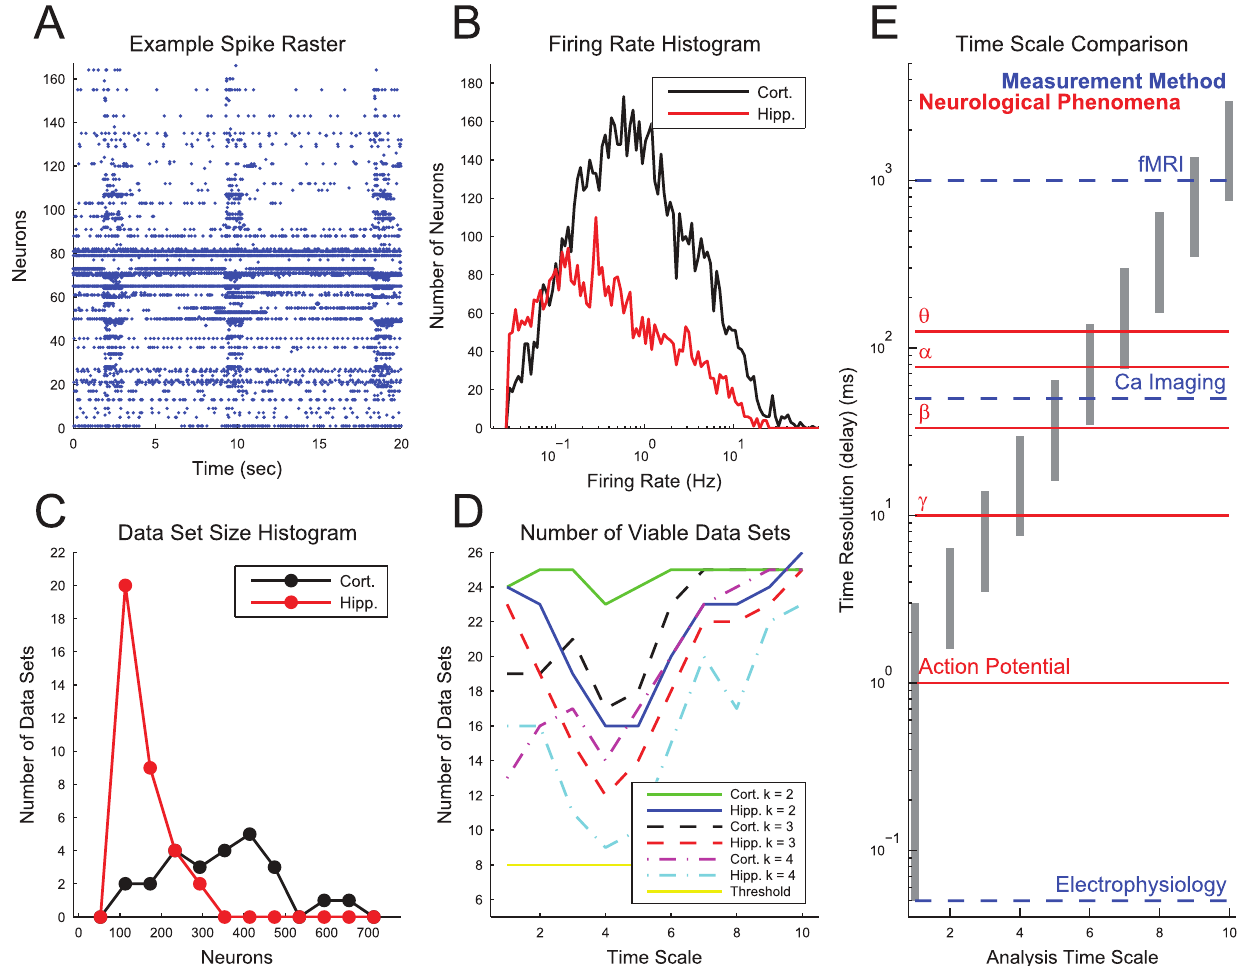
Fig. 1. Analysis time scales and basic data properties. ( A ) Example spike raster from a cortical recording. ( B ) Firing rate histogram of neurons in all hippocampal and cortical recordings. ( C ) Histogram of the number of neurons in each recording. ( D ) The number of viable data sets or recordings. Data sets were deemed viable if they produced sub-networks with at least 50 neurons and a given average degree (k). We used sub-networks with k 5 3 throughout the analysis. ( E ) Time resolutions for the 10 discrete time scales used in this analysis in comparison to the approximate time scales for various neurological phenomena and measurement methods. Note that some measurement methods (e.g. MEG and EEG (forms of electrophysiology), as well as fMRI) are not capable of recording the activity of individual neurons, unlike calcium imaging or cellular electrophysiology (as was used in this study). The analysis time scales were chosen to logarithmically span many neurological time scales and they allowed us to compare network structure on this wide range of time scales. Note that the analysis time scales overlap to ensure that all phenomena are adequately